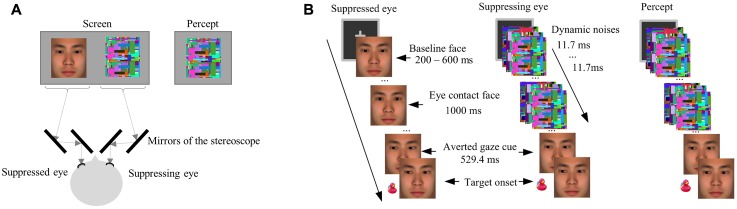
(A) A schematic drawing of the arrangement of the stereoscope and screen in Experiment 2. The stereoscope delivered different stimuli to each eye. The dashed line showed the path of light from the screen to the eyes of a participant. (B) An illustration of a critical trial in the eye-contact + congruent condition in Experiment 2. The target was presented left to the central face.